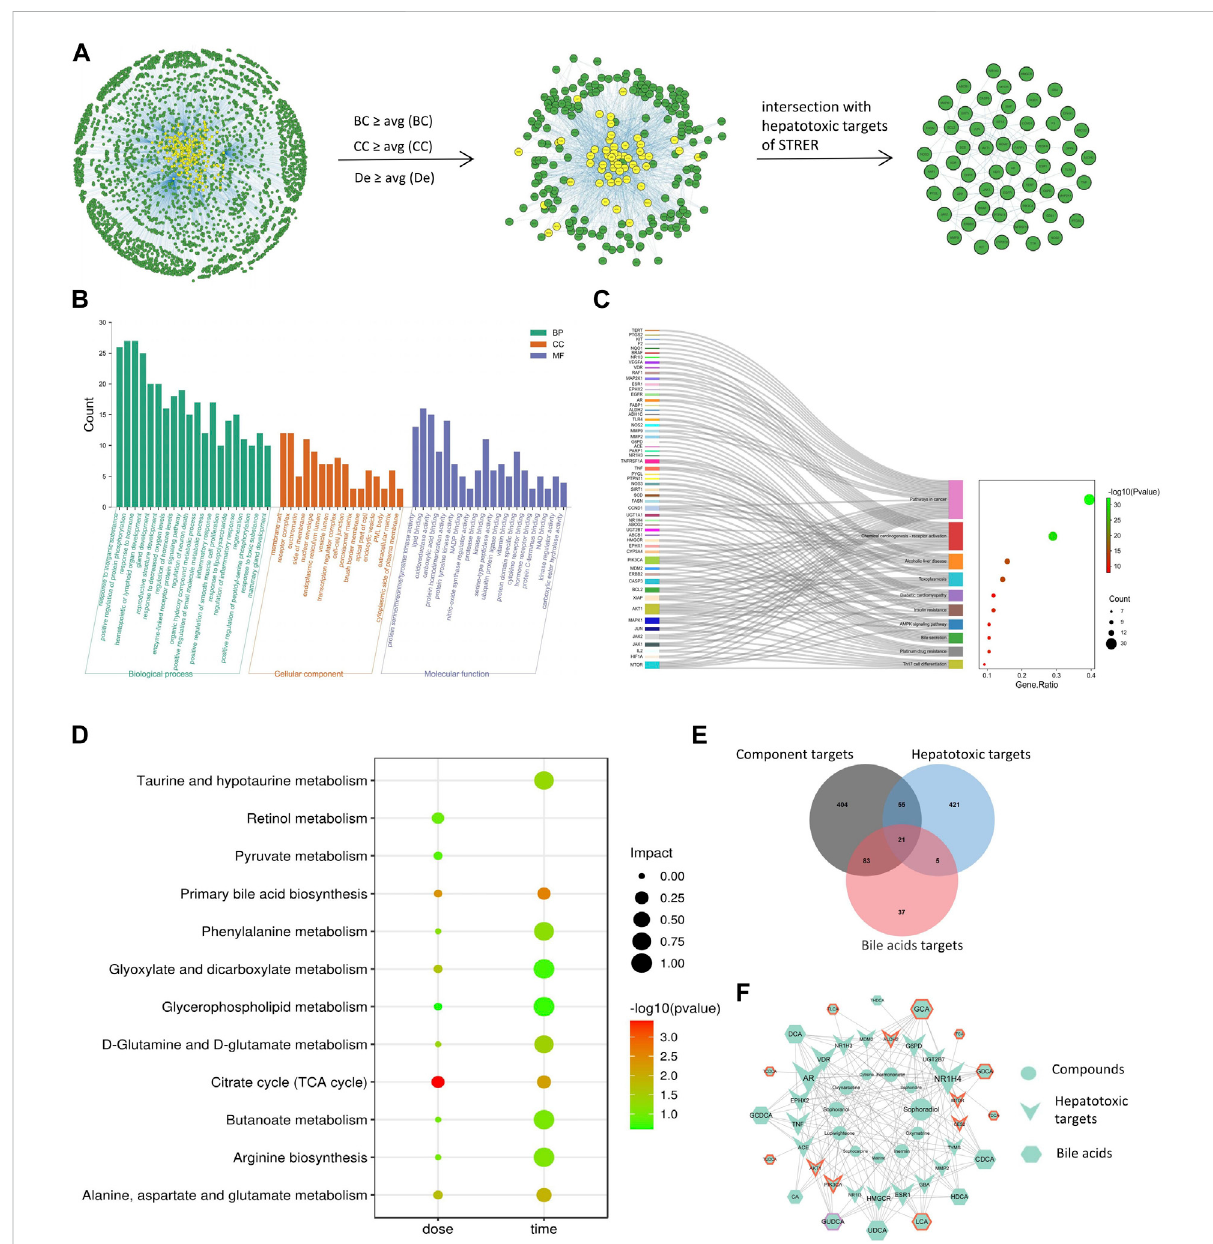
FIGURE 1 NetanalysisofSTRERhepatotoxicsubstancebasis,targetandmetabolitesbasedonSysT. (A) PPInetworkofSTRERhepatotoxictargetsandhub nodes screened by network parameters. (B) GO analysis in three terms including biological process (BP), cellular component (CC), and molecular function (MF). (C) KEGG analysis of STRER hepatotoxic targets. (D) KEGG pathway enrichment analysis of differential metabolites from non-targeted metabolomics. (E) Venn diagram of intersection genes among STRER hepatoxic components and bile acid targets. (F) The “ compounds- hepatotoxic targets-bile acids ” network. The red and purple border respectively represents time-related and dose-related targets and bile acids, while the others are common to